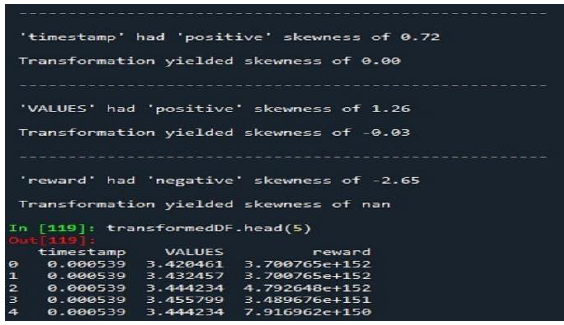
Fig 10. Skewness transformed data